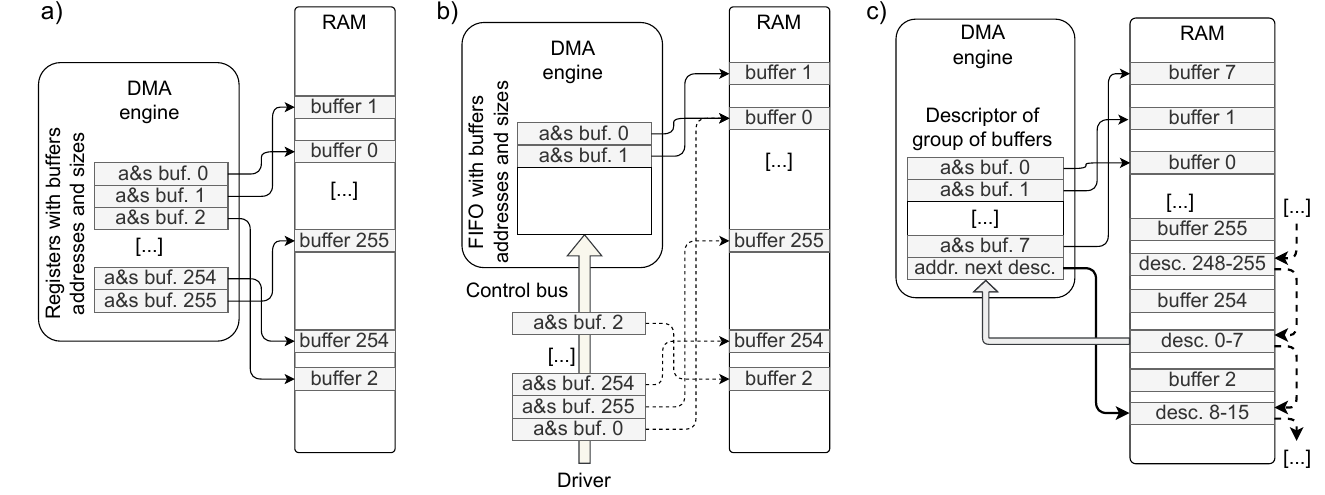
Figure 3. Possible DMA designs working with SG buffers. The large SG buffer consists of multiple small, physically contiguous buffers. The example shows the continuous transfer where the SG